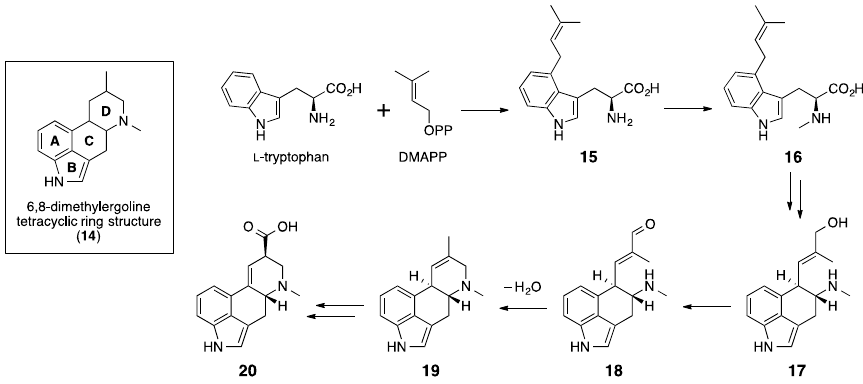
Figure 10. Proposed biosynthetic pathway of D -lysergic acid 20 [53], having the principal 6,8-dimethylergoline tetracyclic ring structure 14 of ergot